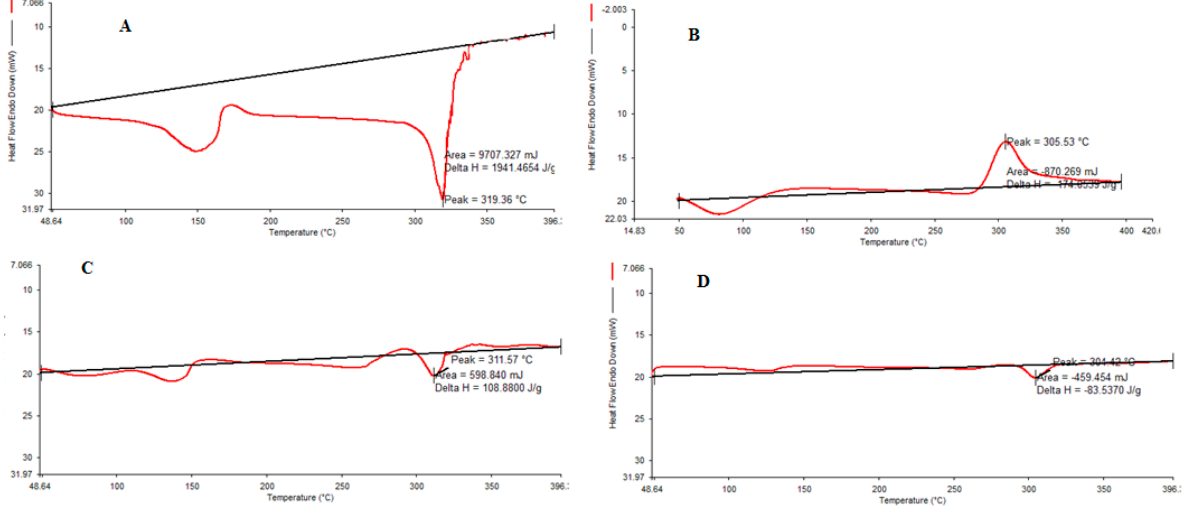
Figure 2. Differential scanning calorimetry (DSC) thermogram of ( A ) pure CHCl, ( B ) CS, ( C ) CHCl-CS physical mixture and ( D ) NPs.